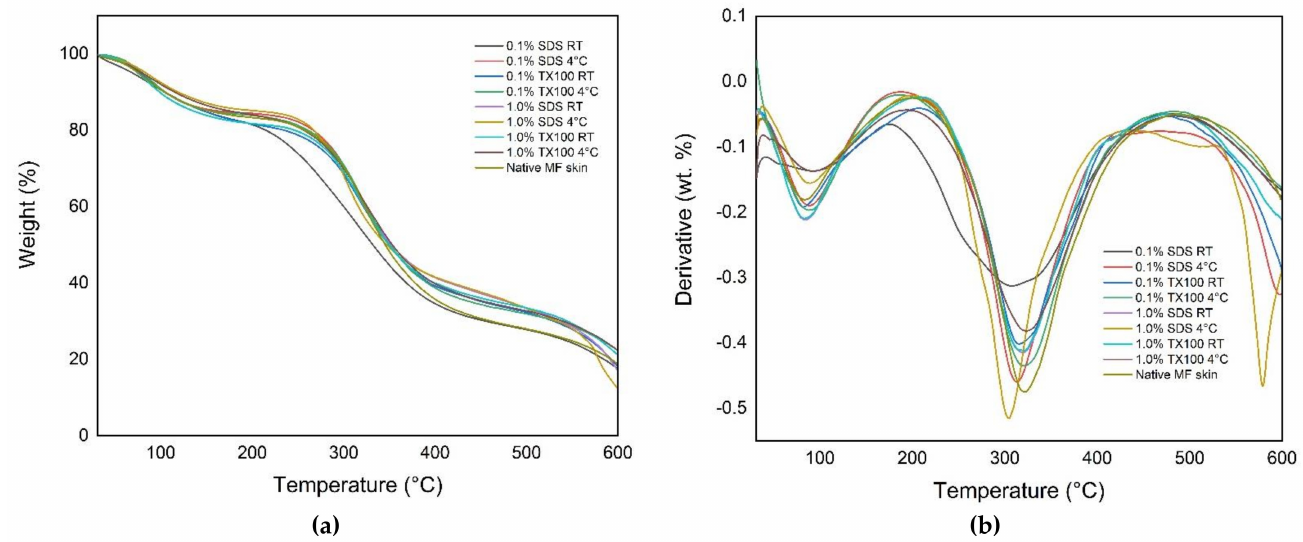
Figure 5. Thermal gravimetric curves for native and decellularized ECM: ( a ) %weight loss; ( b ) deriva- tive of the %weight